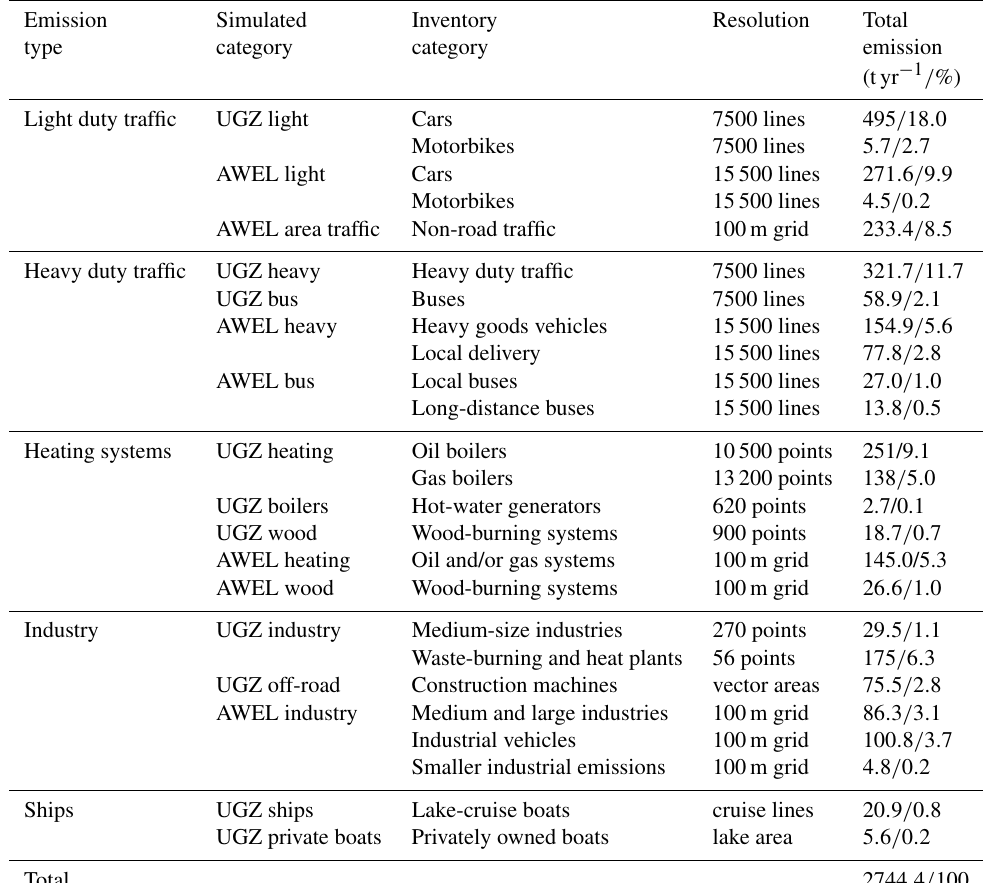
Table 1. Description of NO x emission inventories in Zürich as used in GRAL simulations. Emissions inside the limits of the city of Zürich are provided by UGZ, emissions for the rest of the domain by